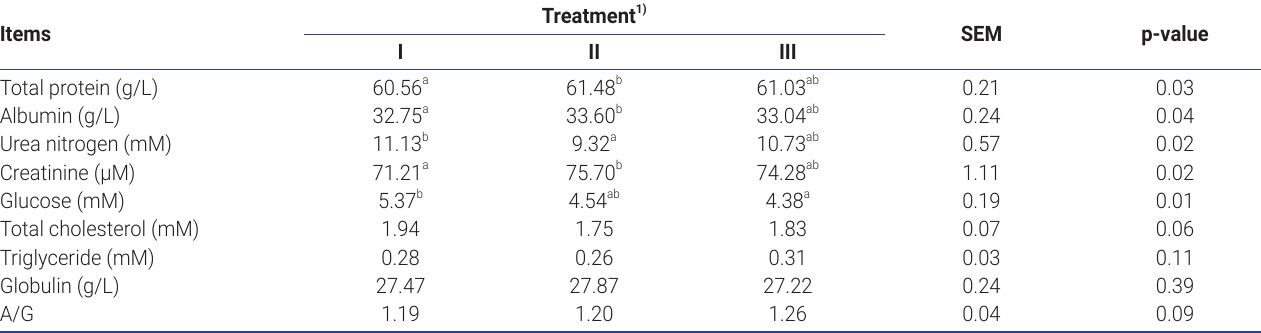
GAA+0.08% RPM. a,b Within a row, means without a common superscript differ